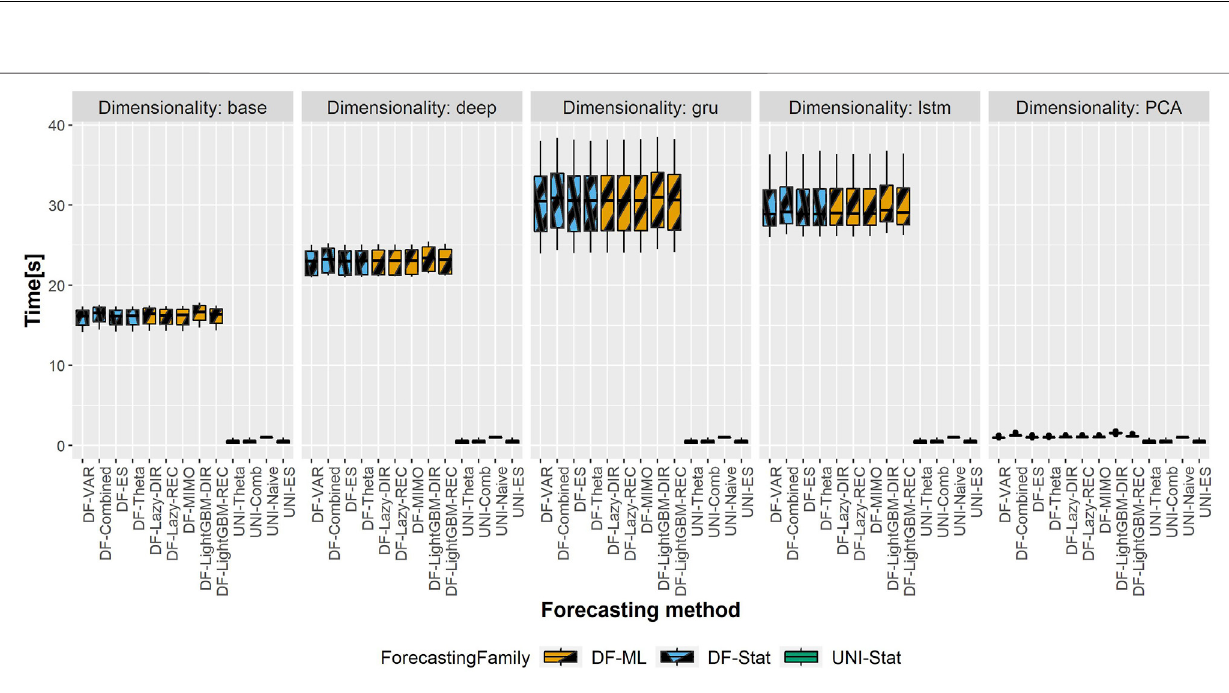
Frontiers in Big Data |